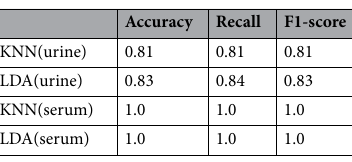
Table 4. KNN and LDA classification